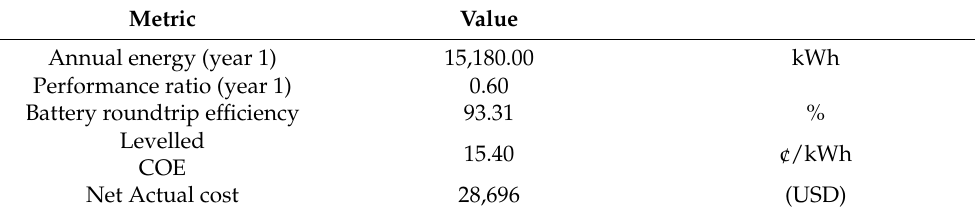
Table 5. Summary results for the operating system at the best tilt and azimuth